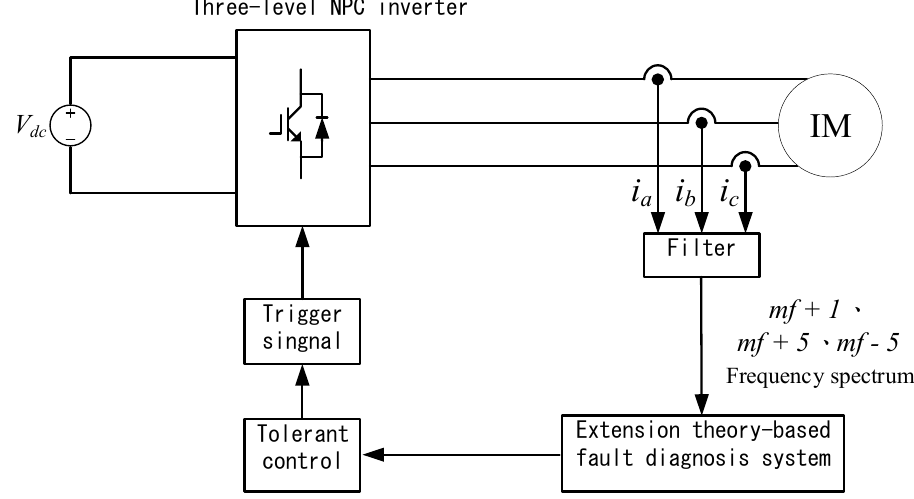
Figure 1. Framework for the extension theory-based fault diagnosis and tolerant control system for neutral-point clamped-type (NPC-type) inverters.